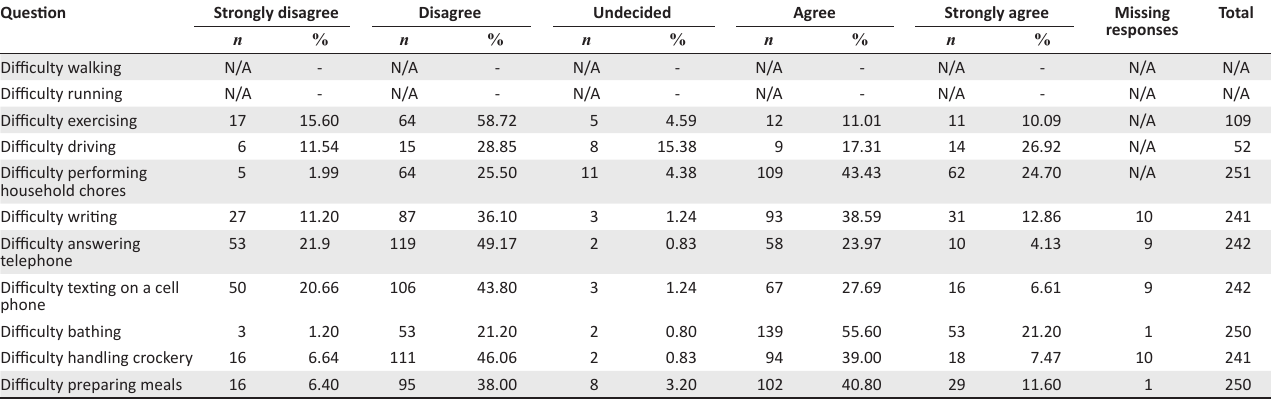
TABLE 2: The impact of upper limb fractures on daily functioning ( n = 251).